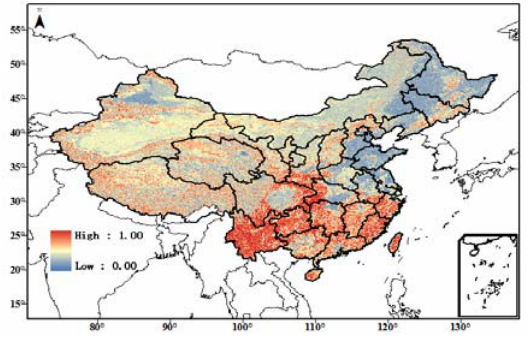
Figure 3. LS map of China based on